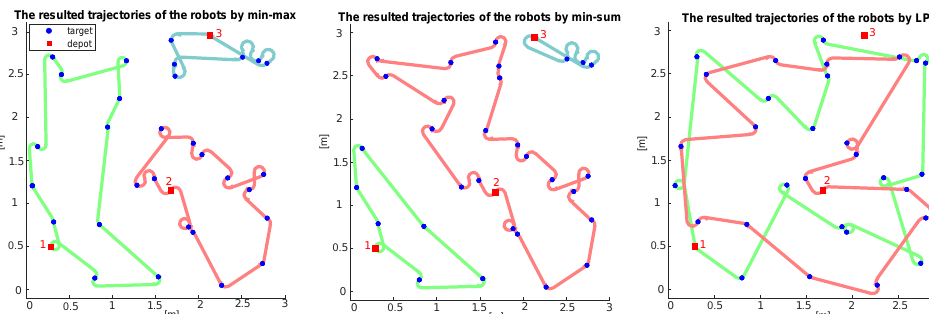
Figure 2. Three solutions were derived from different approaches for 3 robots with 30 tasks. The numbers next to the depots represent the index of the robots. The green, red, and blue paths represent the trajectories for robots 1, 2, and 3, respectively. The last task completion times for the proposed heuristic, min-sum heuristic, and LP rounding method are 8360, 11,445, and 12,309 s, respectively. The computation times for the proposed heuristic, min-sum heuristic, and LP rounding method are 2.43, 0.78, and 6495.11 s, respectively.